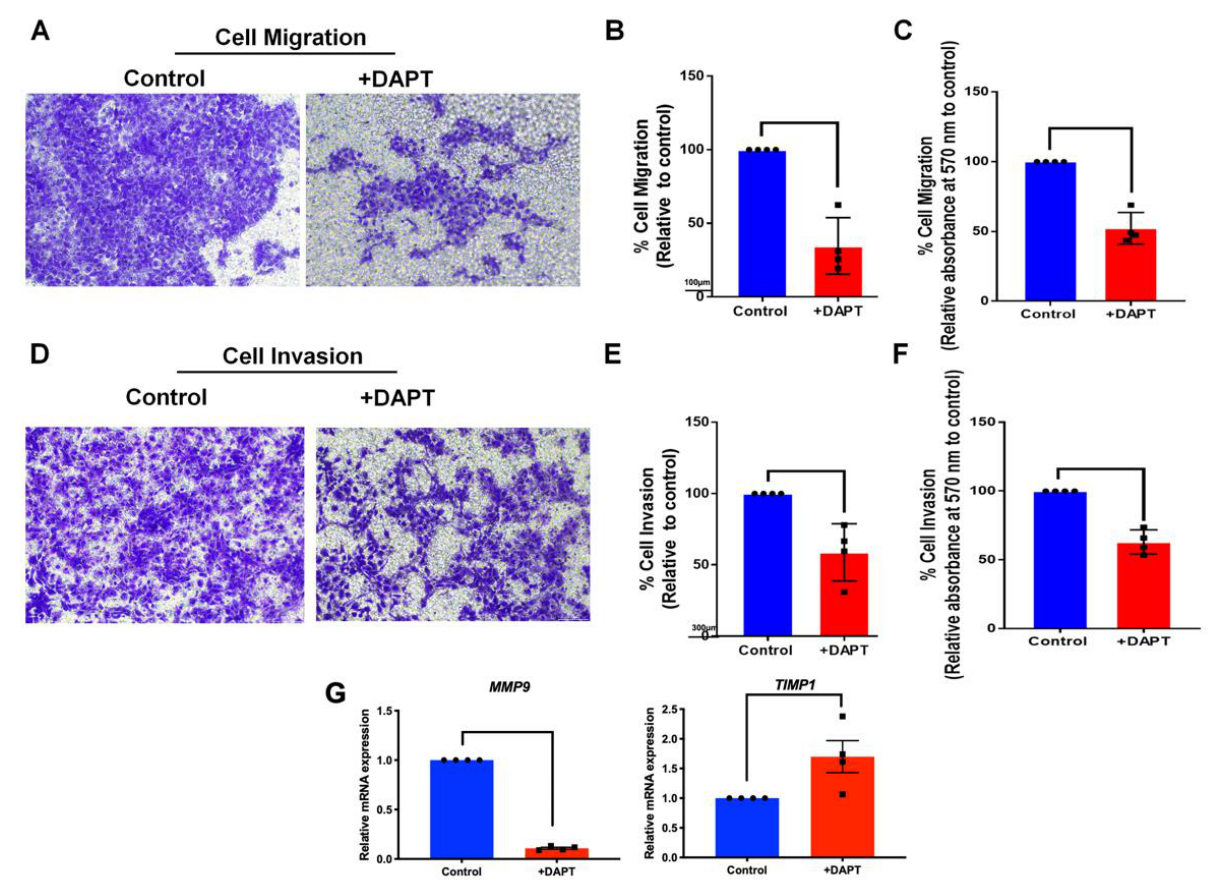
Figure 7. DAPT inhibited HSC-4 cell migration and invasion. The cells were treated with DAPT for 24 and 30 h for the cell migration and invasion assay, respectively ( n = 4). ( A , D ) The image represents the cells that migrated or invaded the lower side of the transwell membrane. ( B , E ) The cell migration and invasion percentage was calculated. ( C , F ) The stained cells on the lower side of the transwell membrane were solubilised and the absorbance was measured at 570 nm. ( G ) The mRNA expression was examined using a real-time polymerase chain reaction. Bars indicate a significant difference between groups ( p < 0.05).